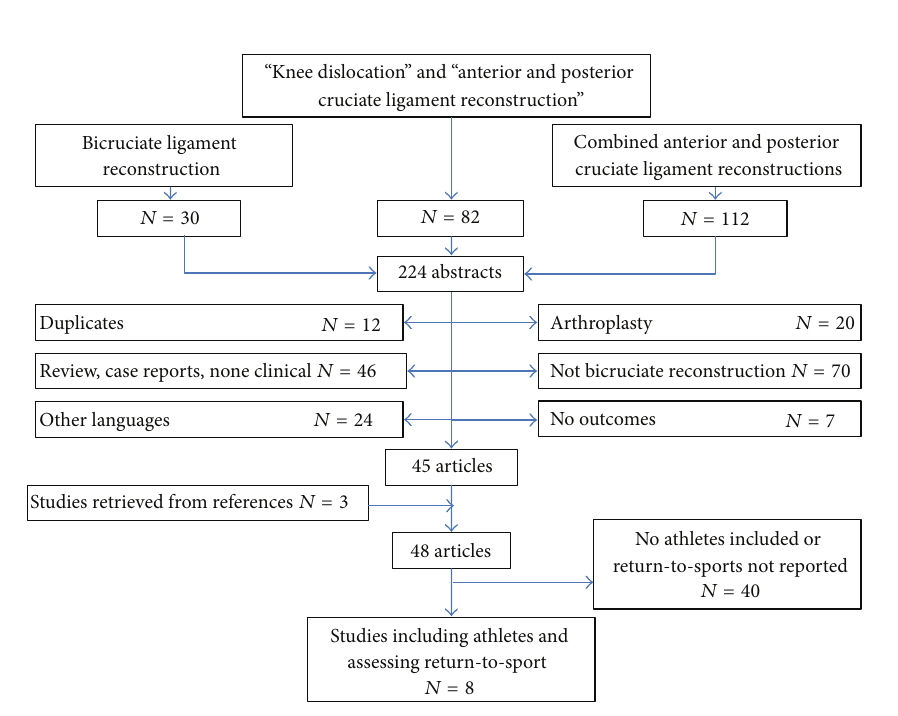
Figure 5: Flowchart of the systematic